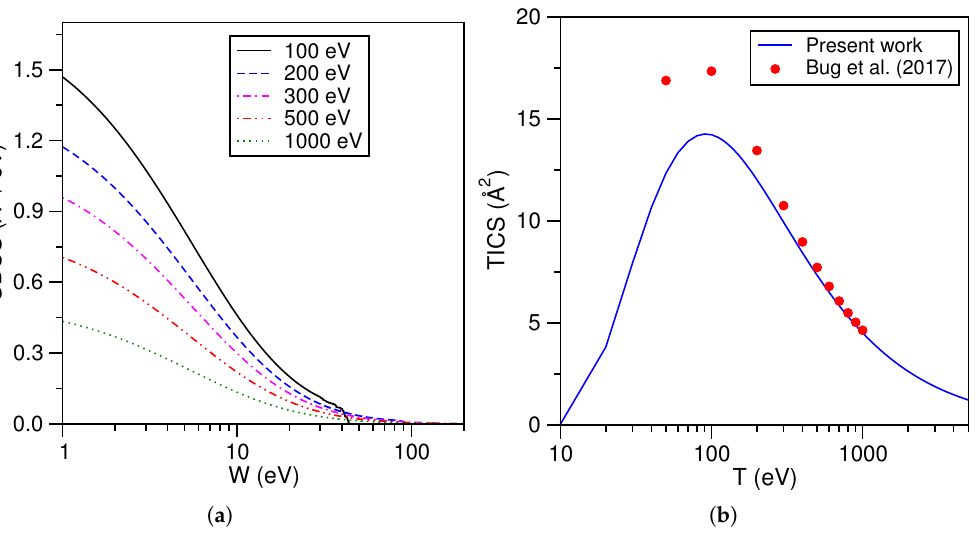
Figure 13. ( a ) Electron-impact SDCS for Purine at different primary electron energies. ( b ) TICS for electron-impact ionization of Purine in the primary electron energy range. The filled circles represent the recommended data points of Bug et al.